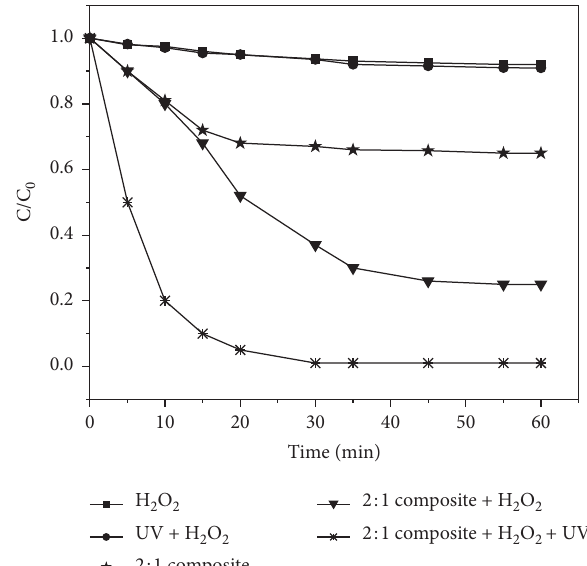
Figure 10: MO removal over 2:1 composite as a function of time. Reaction conditions: [MB] � 50mg/L, [H and catalyst dosage � 2.5